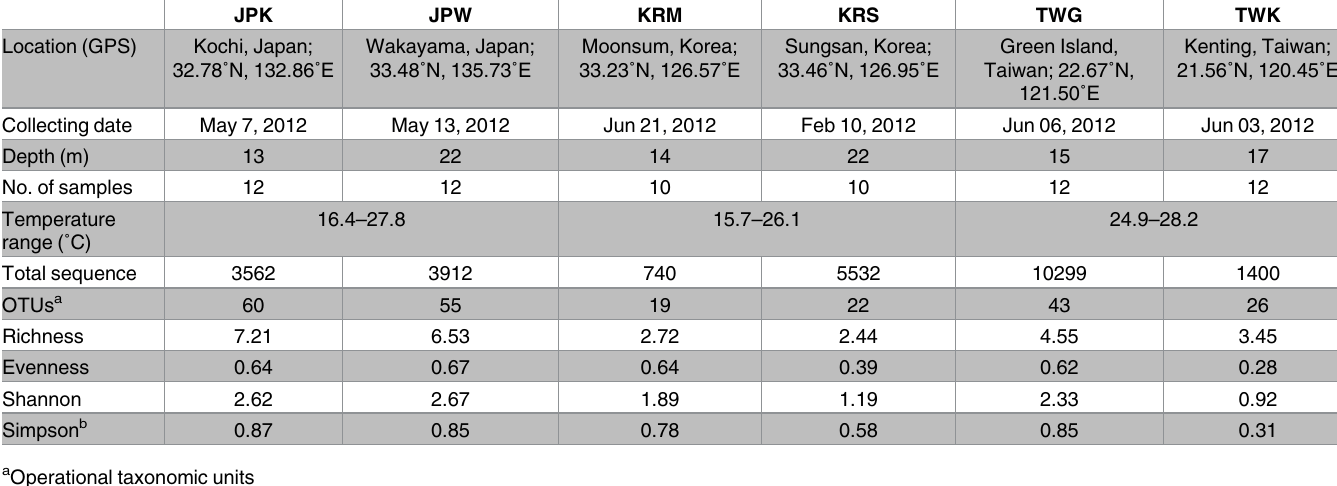
Table 1. Scleronephthya gracillimum sampling information and S . gracillimum - associated microbial diversity